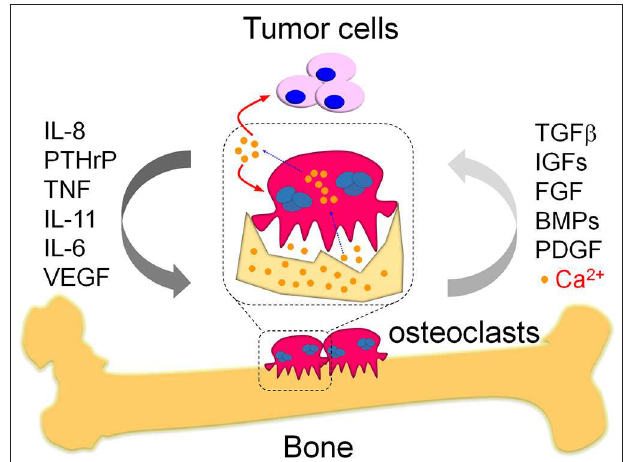
FIGURE 1 | The vicious cycle in bone metastasis. Bone metastasis is highly occurred in breast cancer patients, which results in vicious cycles to further deteriorate the primary tumor burden and promote tumor growth in bone. One kind of the well-known vicious cycles is a systemic response in tumor cells and osteoclasts. Briefly, the migrated tumor cells produce multiple cytokines and eventually enhance osteoclast differentiation as indicated. The pathologically activated osteoclasts heavily destroy bone that release numerous growth factors from damaged bone matrix, which would in turn promote tumor cell growth and therefore form the vicious cycle between tumor cells and osteoclasts during bone metastasis. Except growth factors, the damaged bone also releases large amounts of calcium ions. These calcium ions were specifically released in the sealing zones where mature osteoclasts tightly attached with the bone. The mature osteoclasts also exhibit specialized plasma membrane in the sealing zone, named as ruffled border. The ruffled border facilitate the release of calcium ions from bone via the vesicular transport in osteoclasts. The released calcium ions might further